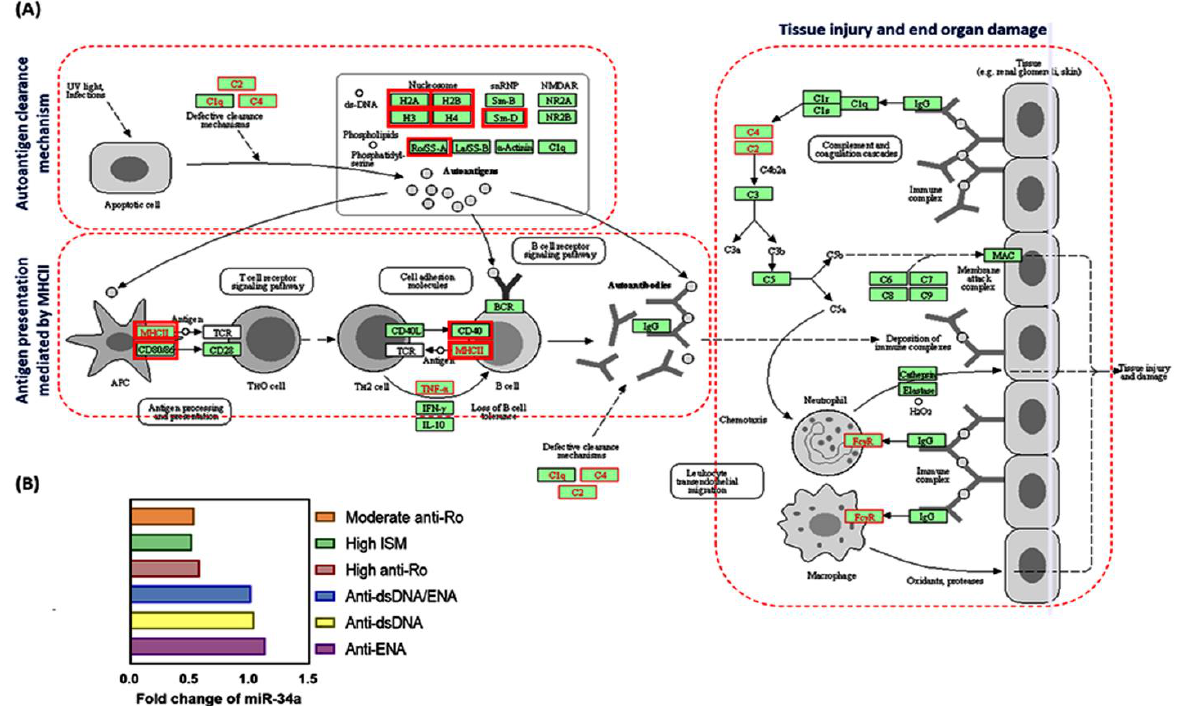
Figure 1. SLE is an autoimmune disease characterized by augmented self-antigen specific auto-antibodied production that contribute to a pleotropic clinical presentation. ( A ) MicroRNA-34a is significantly enriched in the SLE pathway. Gene targets of miR-34a were labeled in red bold-colored boxes in the SLE KEGG pathway (hsa05322) [30]. MiR-34a target genes code for different histone family members (i.e., H2A, H2B, H3, and H4) that are implicated in tolerance mechanism/autoantigen clearance and the “major histocompatibility complex class II (MHCII)”, which plays an essential role in antigen presentation [31]. All the stages of antigen processing and autoantibodies generation lead to tissue injury and end-organ damage (left panel) [32]. More detail for gene names and functions are provided in Table S1. Data source: Diana Lab tools (DIANA TOOLS-Reverse Mirpath (grnet.gr) (last accessed on 25 May 2021). ( B ) The expression level of the MIR34A gene in SLE patients in independent cohorts from Gene Expression Omnibus datasets (GSE80183 and GSE72509), Anti-Ro: a type of RNA-binding proteins; ISM: Interferon Signature Metric; dsDNA: double-stranded DNA; ENA: extractable nuclear antigens (RNAassociated proteins) [33,34].